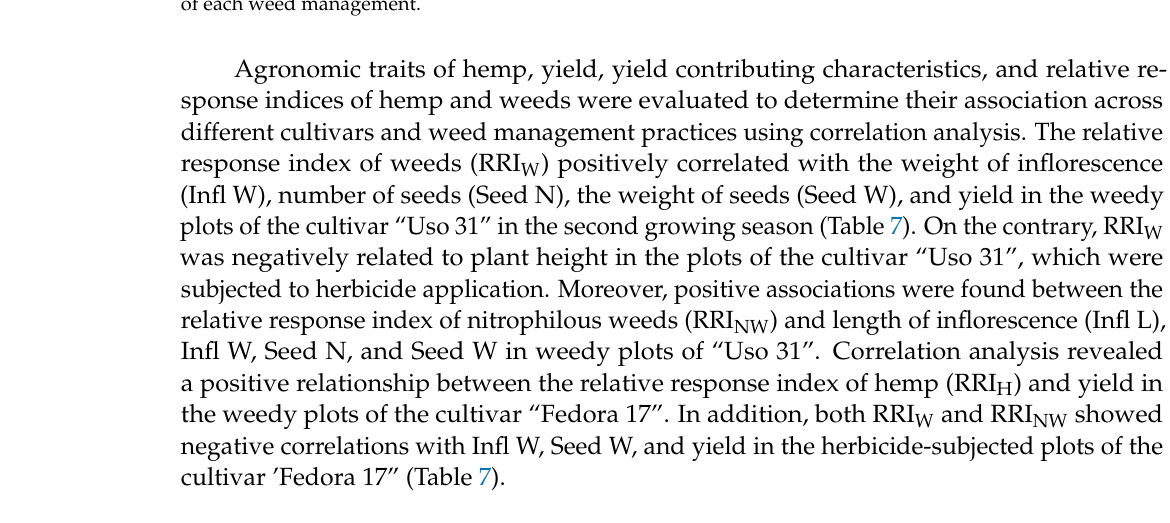
Table 7. Pearson correlation coefficients and significance levels between relative response indices (RRI of hemp (RRI H ), RRI of weeds (RRI W ), RRI of nitrophilous weeds (RRI NW ), and RRI of non- nitrophilous weeds (RRIN NW )) and agronomic traits (Inflorescence length (Infl L) and weight (Infl W), Seed number (Seed N) and weight (Seed W) per inflorescence, seed yield) of two hemp cultivars (Uso 31; Fedora 17) for weedy and herbicide-treated (HT) in 2020 growing season. Uso 31 Fedora